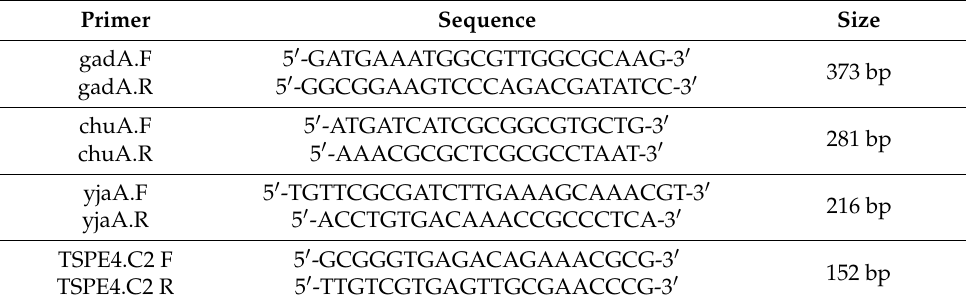
Table 2. Primers used for determination of phylotypes.